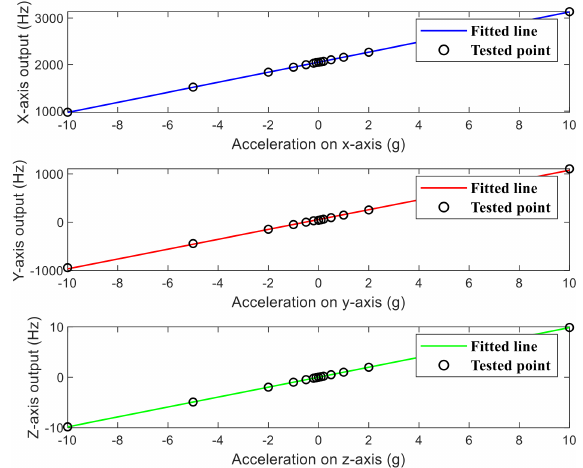
Figure 21. Linearity and range of tri-axis